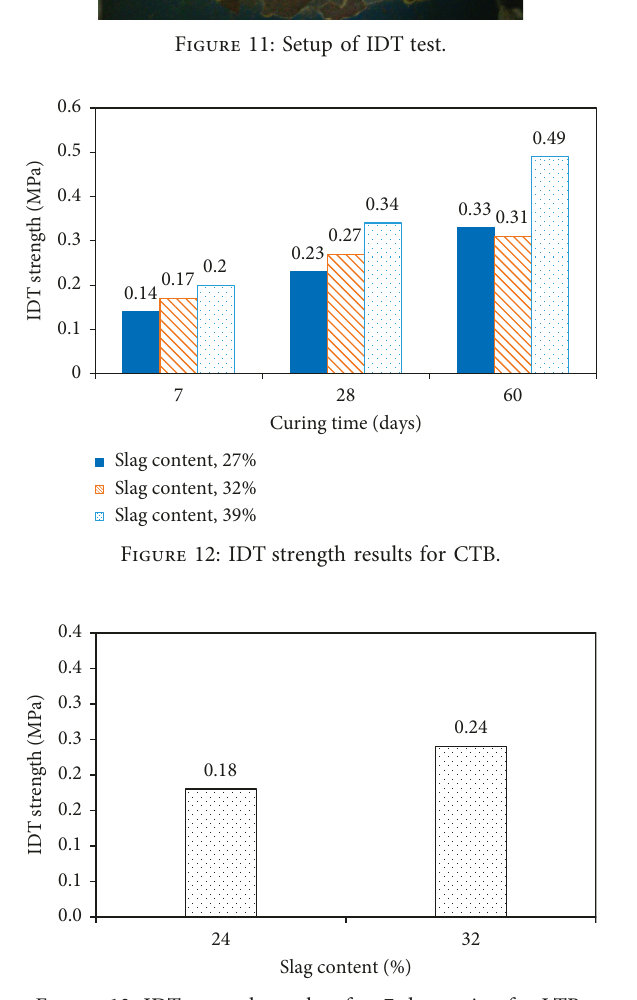
Figure 13: IDT strength results after 7-day curing for LTB.